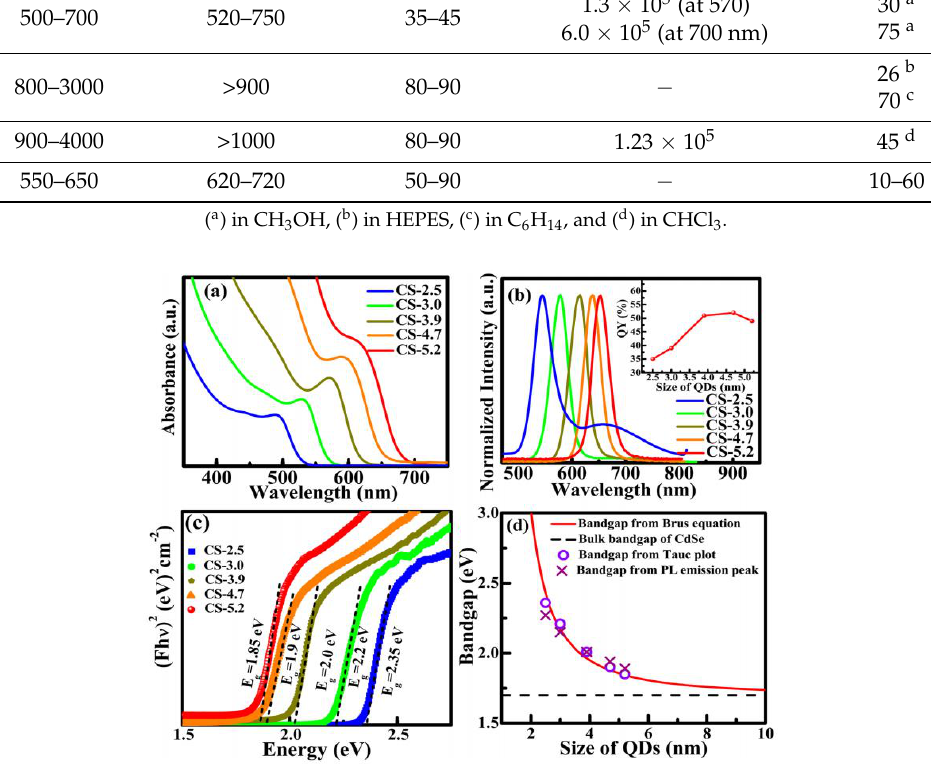
Figure 9. ( a ) Absorption spectra, ( b ) normalized emission spectra, ( c ) Tauc plot obtained from diffuse reflectance spectra, and ( d ) the comparison of the experimentally determined bandgap of CdSe QDs with theoretically calculated values using Brus equation. Te emission spectra were recorded using an excitation wavelength of 400 nm. The inset in (b) shows the value of the corresponding quantum yield of different sized QD and the fat line (at 1.7 eV) in (d) indicates the bulk band gap value of CdSe. The band gap is calculated experimentally from the Tauc plot and from the PL emission peak position (d) . Reproduced from [117], with permission from Nature Publishing Group, 2018 . Table 5. Main spectroscopic characteristics of luminescent semiconducting nanocrystals for optical fluorescence imaging. ε is the molar extinction coefficient associated with the main absorption, FWHM the width at half height of the emission band and Ф f the quantum yield.